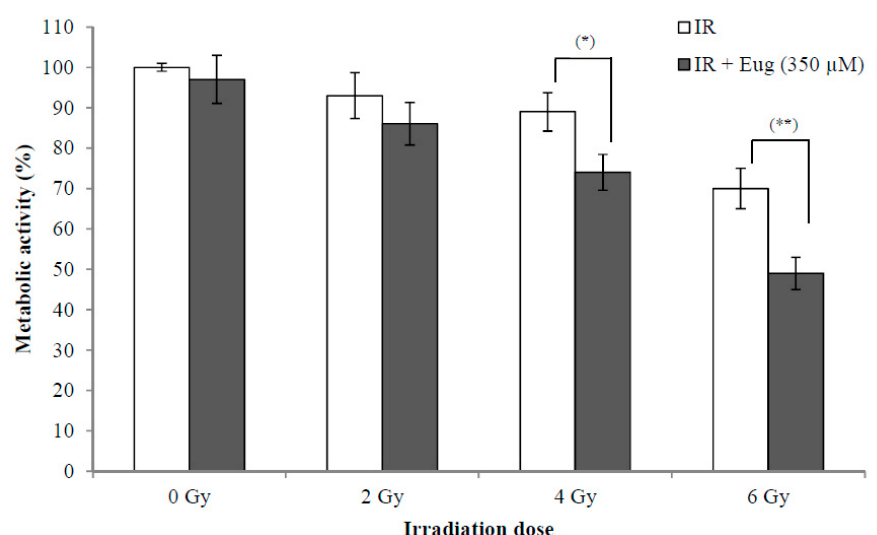
Figure 3. Effect of eugenol on sensitivity of HeLa cells to radiation. HeLa cells were treated, in triplicate, with eugenol (350 µM) for 6 h and then irradiated with (0, 2, 4, and 6 Gy) X-rays and the medium was replaced with a fresh medium. The survival of cells after 24 h, estimated by CCK-8, was expressed as a percentage relative to that of non-radiated cells treated with medium only. Data represent mean ± SD. * p < 0.05 and ** p < 0.01 compared to cells not treated with eugenol.